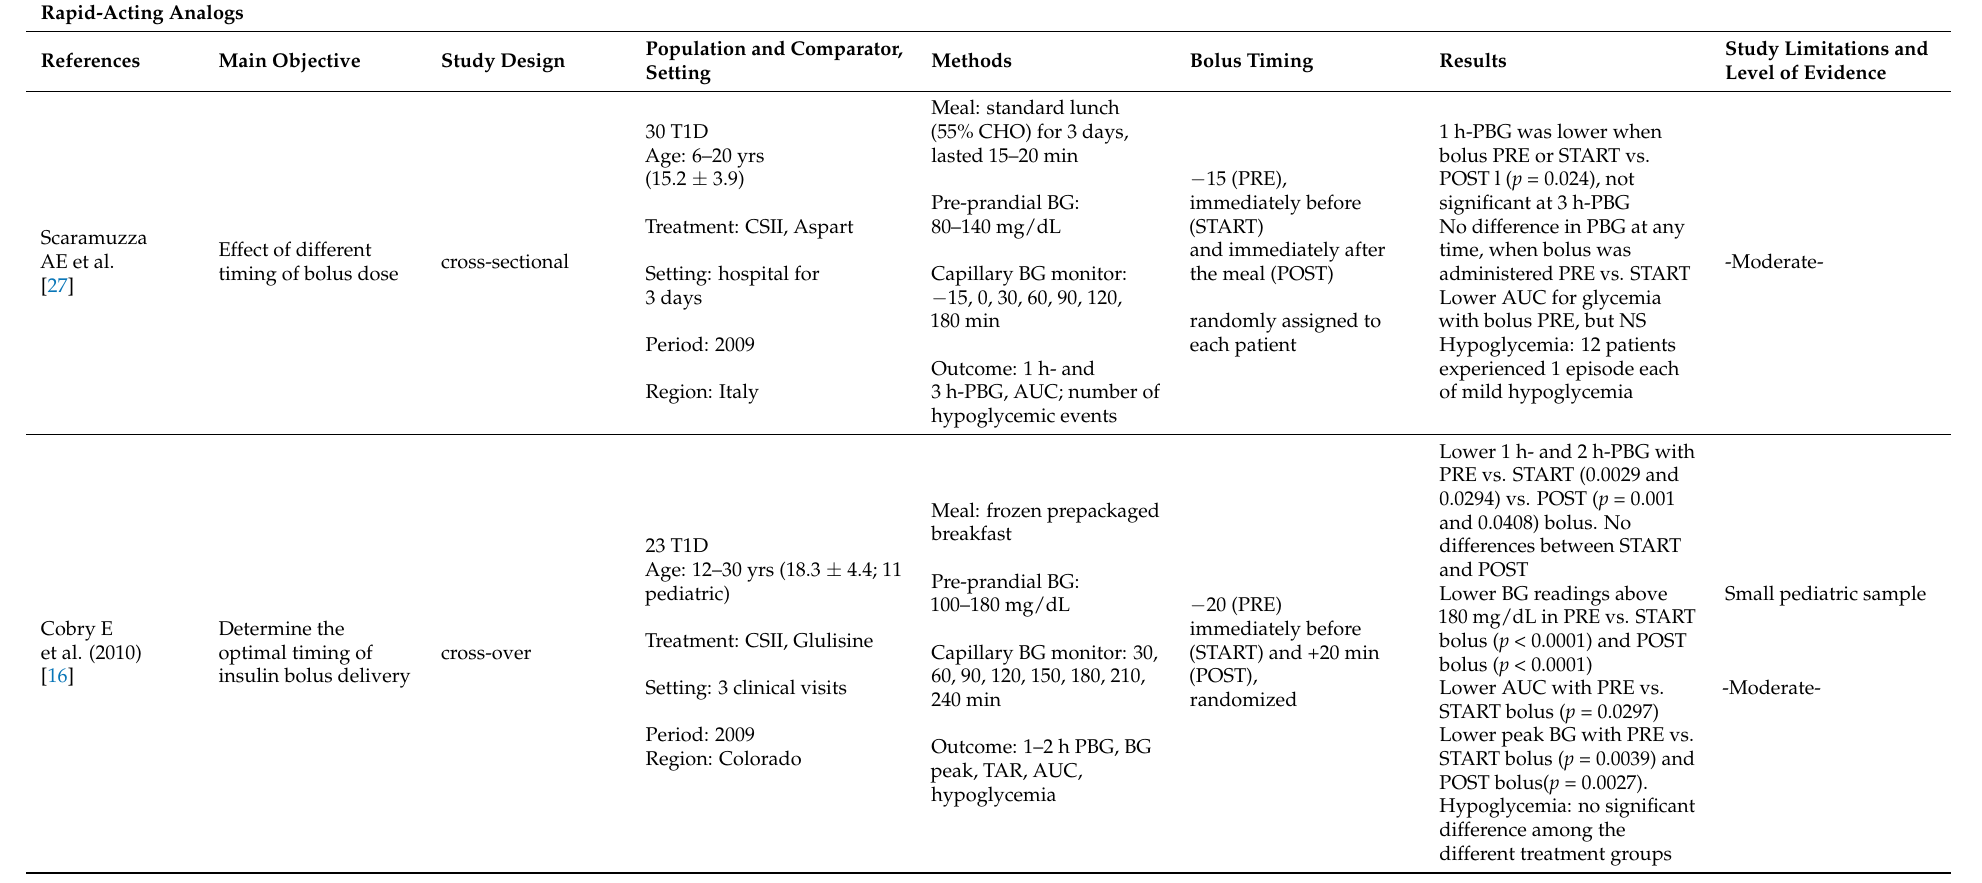
Table 1. Literature analysis after PICOS selection: description, summary of the studies and grading of evidence using the GRADE system. PRE: − 20 to − 10 min before the meal; START: − 2 to 0 min; POST: 10–20 min after the start of the